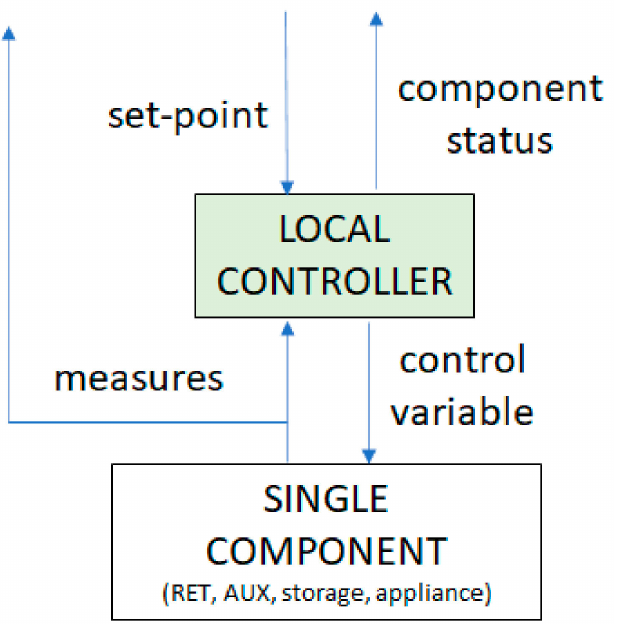
Figure 10. Real time control of the single component of the energy